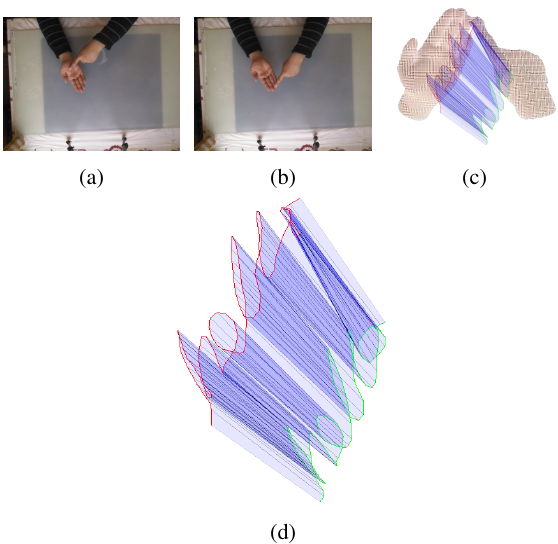
Figure 12: Trajectories of tracking multi-hand interaction. (a) and (b) show the scenario of multi-hand interaction with occlu- sion. (c) and (d) show result of the control vector from hand centroid (green) to index fingertip (red). The index fingertip in the occluded region is reconstructed by using the PCA